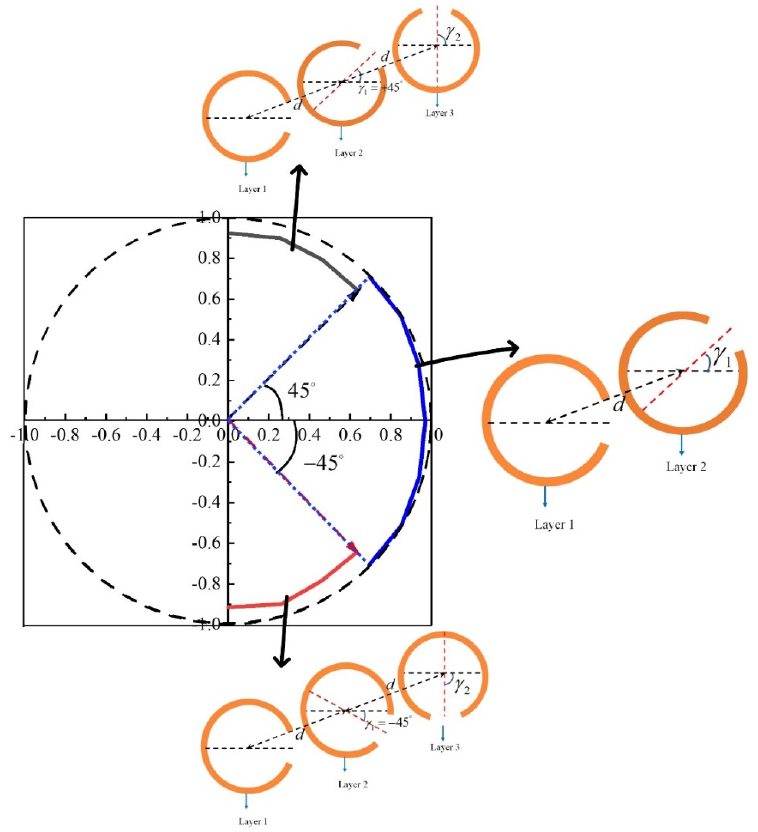
Figure 5. Linear polarization orientation angle modulation and its corresponding circular − shape SRR structure.